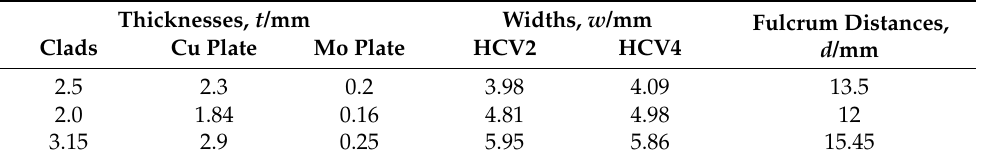
Table 3. Dimensions ( t , w ) of three-point bending test specimens and fulcrum distances ( d ) in the specimens for HCV2 and HCV4 clads: d = 3 t + φ ( φ = 6 mm).